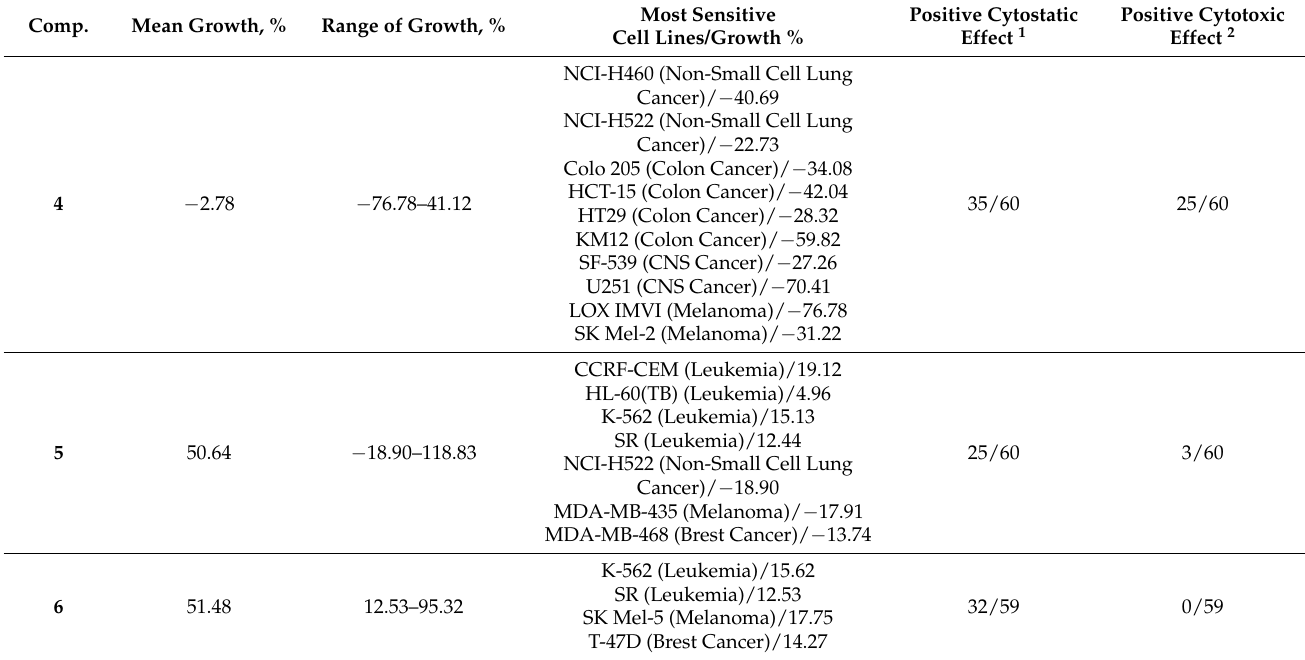
Table 3. Anticancer Screening Data in Concentration 10 µ